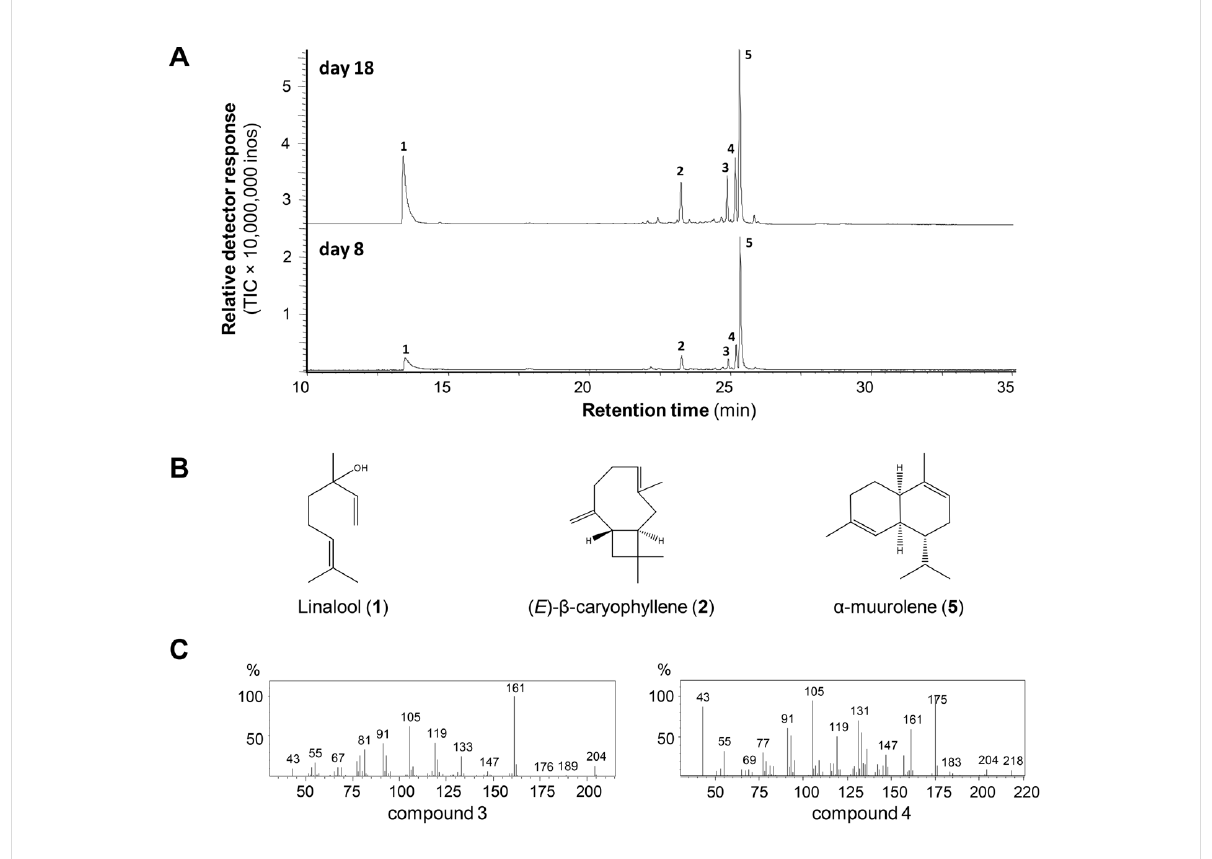
Figure 1: Plasmodia of P. polycephalum emit a mixture of volatiles predominated by terpenoids. A) GC chromatograms of volatiles collected from plasmodia of P. polycephalum grown at 8 and 18 days after transferring to a fresh agar plate. This experiment was repeated three times with similar results. 1 , linalool; 2 , ( E )- β -caryophyllene; 3 , unidentified sesquiterpene hydrocarbon (compound 3 ); 4 , unidentified putative sesquiterpene aldehyde (compound 4 ); 5 , α -muurolene. B) Structures of known terpenoids. The structure of compound 2 shows the ( − )-enantiomer of ( E )- β